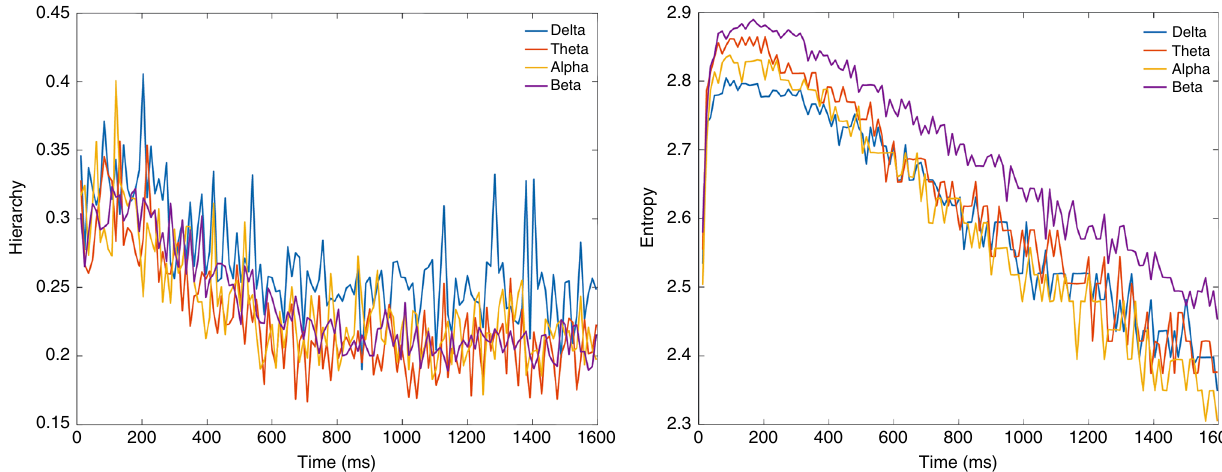
Fig. 7 Timescale in MEG data. Figure shows the results of using hierarchy (left) and entropy (right) on the different delta (1 – 4 Hz), theta (4 – 8 Hz), alpha (8 – 12 Hz) and beta (12 – 30 Hz) bands of the MEG data in different bin sizes from 10 to 1600 ms, i.e. directly on the empirical data — and thus not using the whole-brain modelling part of the process used for fMRI data. The peaks in entropy and hierarchy for all bands show a peak in the region of around 200 ms, which is similar to the peak found in fMRI and thus suggest a similar richness of the dynamical repertoire